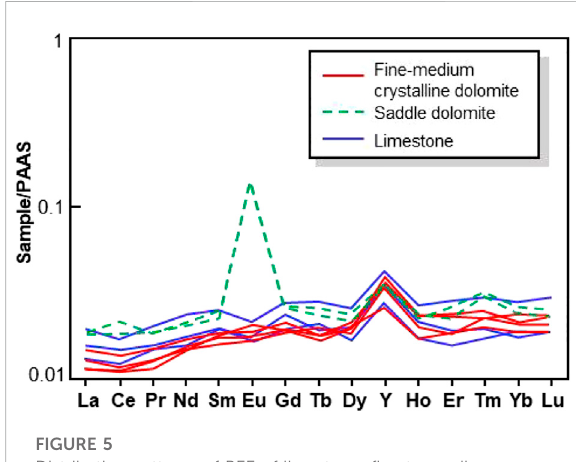
FIGURE 5 Distribution patterns of REE of limestone, fi ne to